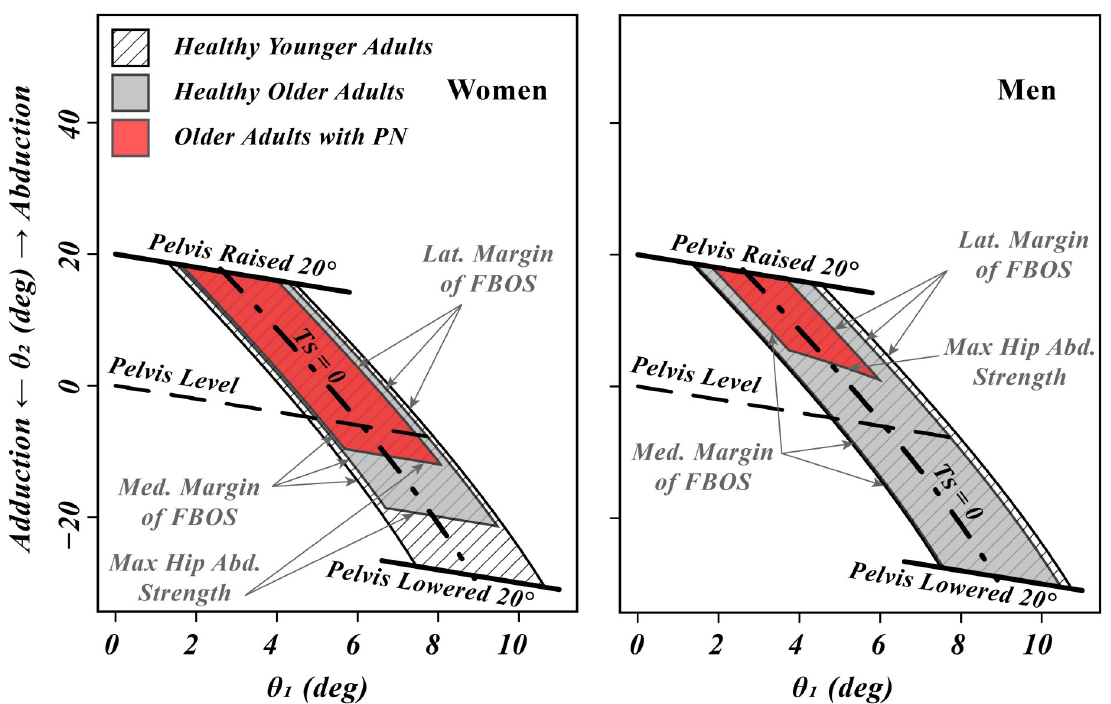
Fig 2. A graphical comparison of the effect of ankle and hip strength on the mean calculated quasistatic active feasible balance region (FBR) for OLB in women (left) and men (right) of different ages and health status. A point on each state-space plot represents a quasistatic state for the OLB double inverted pendulum model with a fixed foot link, where θ 1 is the angle that the stance leg makes with the vertical line and θ is the stance leg’s hip abduction angle (please see Fig 1C). Because of limited ankle and hip strengths and ranges of 2 motion, quasistatic OLB can only be maintained for the states inside the solid lines defining the FBR for each sex and group. The dashed- dot line in the middle of each FBR is the locus of states for which the COM lies in the same vertical plane as the ankle so that no ankle moment is required (T S = 0). The top boundary of the FBR for all groups is the locus of points for which the pelvic inclination angle is raised a nominal 20 º . For healthy young men and women, and healthy older men, the lower boundary of the FBR is the locus of points for which the pelvic inclination angle is decreased a nominal 20 º . However, for healthy older women and older patients with peripheral neuropathy it is the maximum active hip abduction strength that constrains the lower end of the FBR. The left and right boundaries of the FBR are always determined by the medial and lateral margins of the functional base of support,